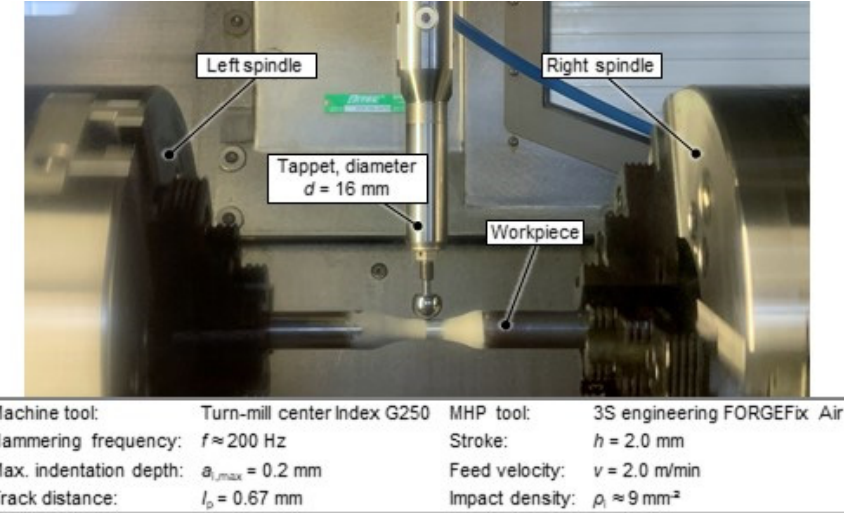
Figure 4. Turn-mill center with process parameters for machine hammer peening (MHP) process.